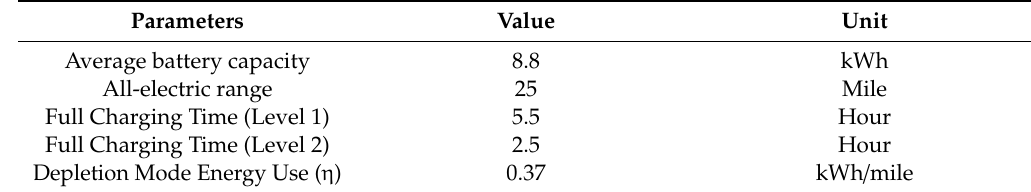
Table 1. Plug-in hybrid electric vehicle (PHEV) Fleet